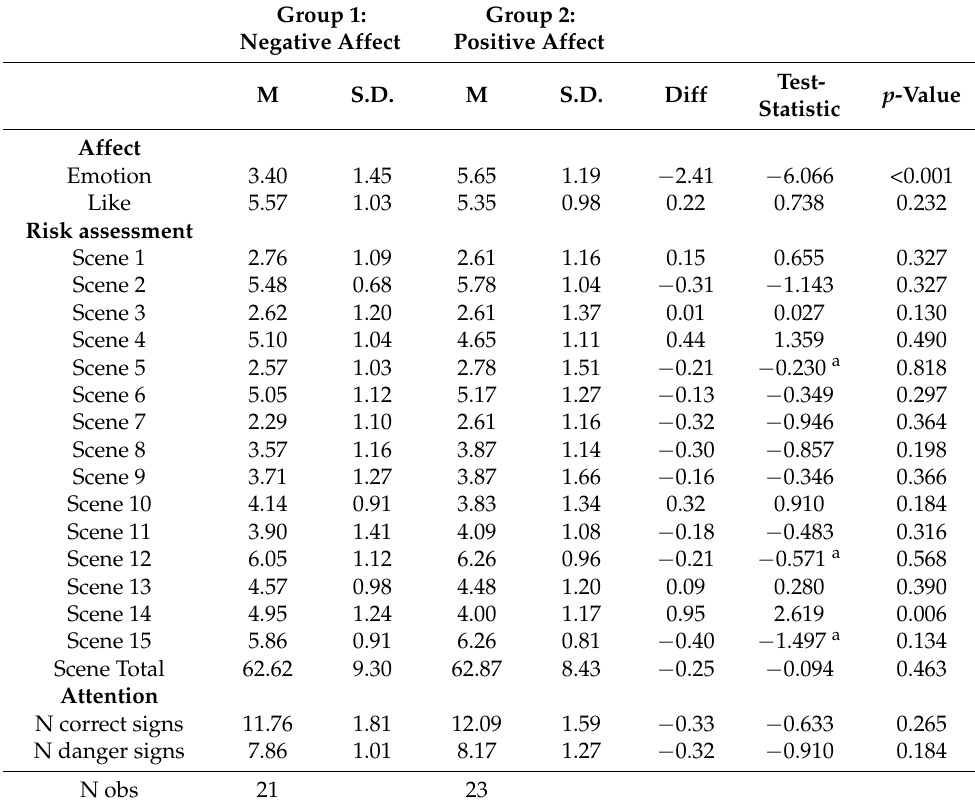
Table 2. Mean responses and bivariate tests of differences between negative and positive affect. Group